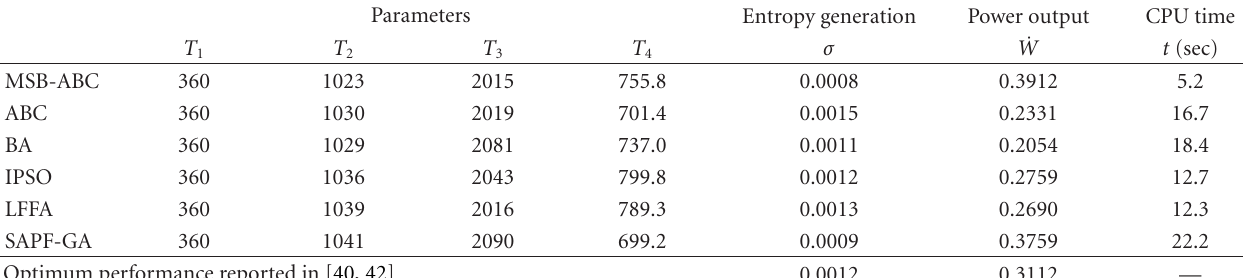
Table 1: Performance of tested algorithm in γ 0 = 1 . 31 and k 1 = 0 .